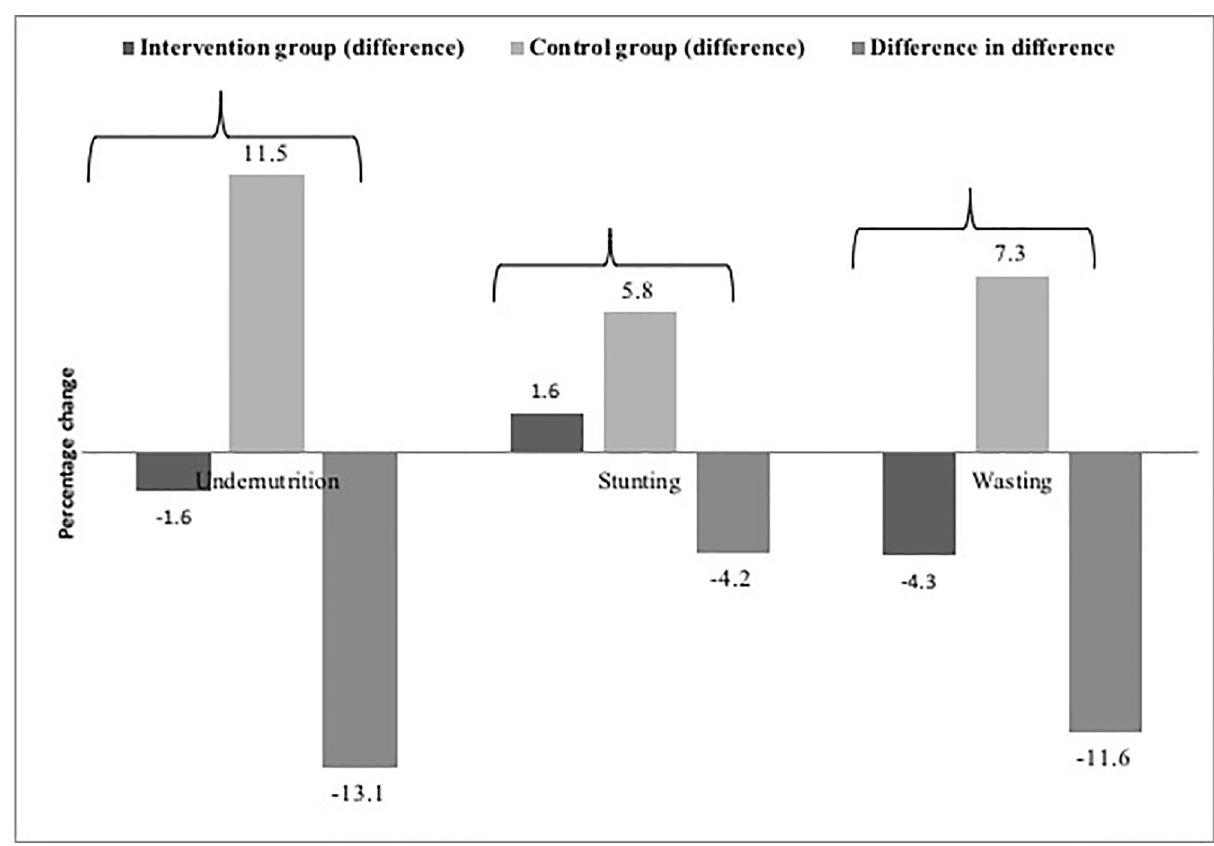
Fig 3. The difference in the proportion of underweight, stunting and wasting in the infants at baseline and end line in the intervention and control